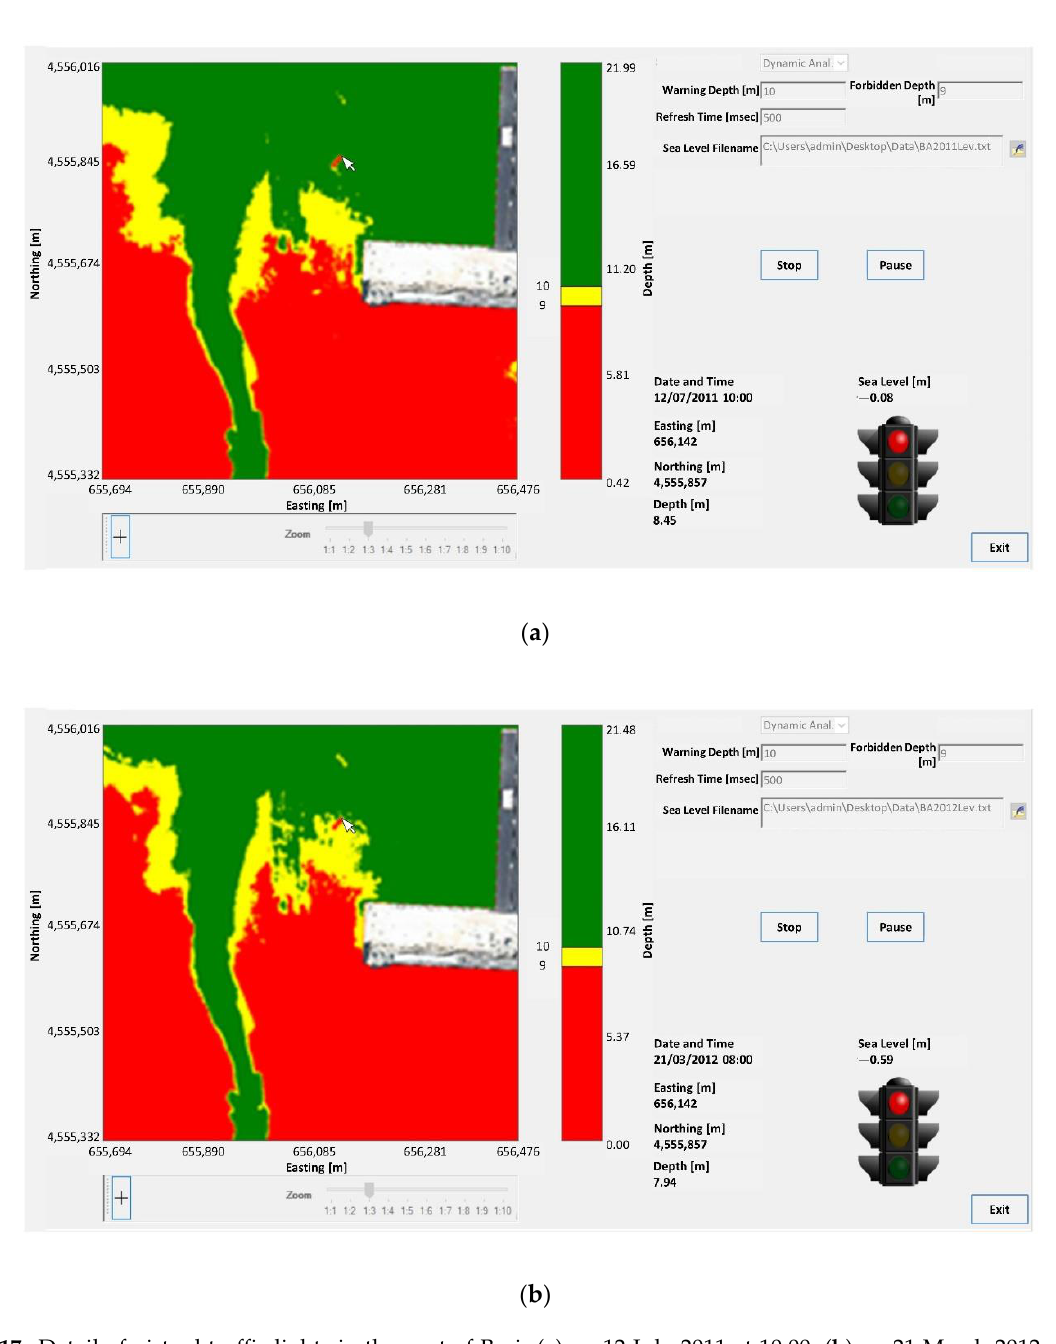
Figure 17. Detail of virtual traffic lights in the port of Bari: ( a ) on 12 July 2011 at 10:00; ( b ) on 21 March 2012 at 08:00; thresholds equal to 9 and 10 m.